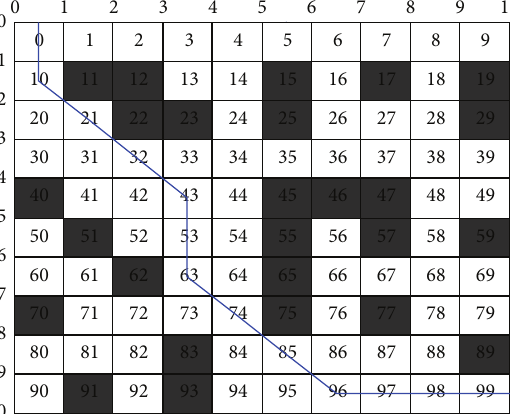
Figure 7: Original route before reducing turns.